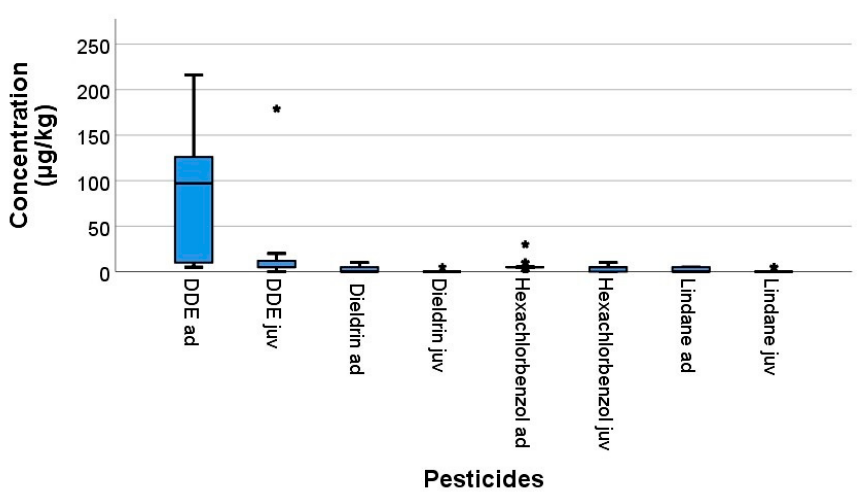
Figure 1. Concentrations of pesticide in organs of common swifts detected in 2016–2018 in µ g/kg wet weight. The box plot shows the median (horizontal line in centre), the 25th percentile (box border at bottom) and the 75th percentile (box border at top). The upper and lower ends of the whisker show the maximum and minimum values. The single data points are outliers. The asterisks are extreme outliers. Table 2. Concentrations of organochlorine pesticides and polychlorinated biphenyls in pooled organ samples of adult and juvenile common swifts detected in each year from 2016 to 2018 in µ g/kg wet weight (ww): Mean ± SD a (Median; Xmin b –Xmax c